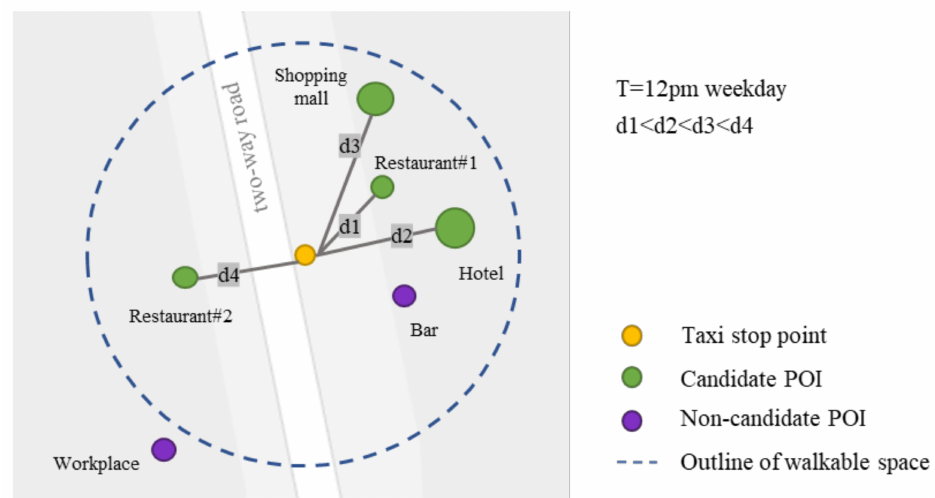
Figure 3. A schematic diagram of activity inference framework.